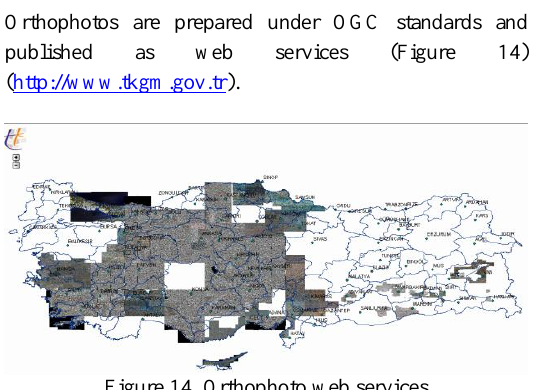
Figure 14. Orthophoto web services Orthophoto services intensively used in decision support and control during renovation cadastral work. Renovation work planned in areas with existing cadastral orthophotos superposed sheets, after digitization. Also the current status of the region is obtained by field studies, digitized maps and orthophotos are superposed. So that the entire system can be controlled, implementation decisions can be taken more quickly (Figure